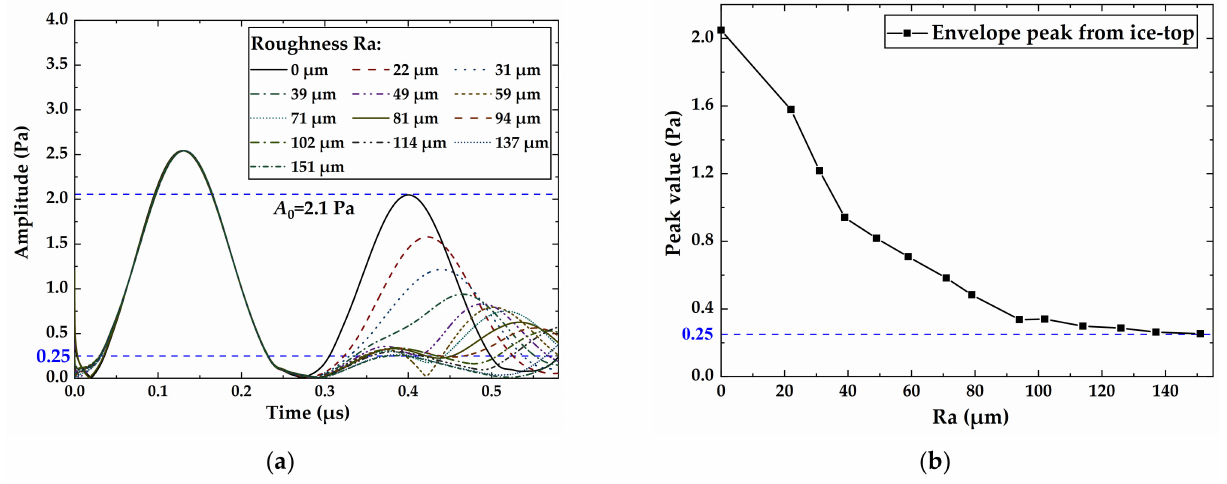
Figure 11. Simulation results for echo envelopes with roughness varying from 0 to 151 µ m: ( a ) Echo envelopes; ( b ) peak